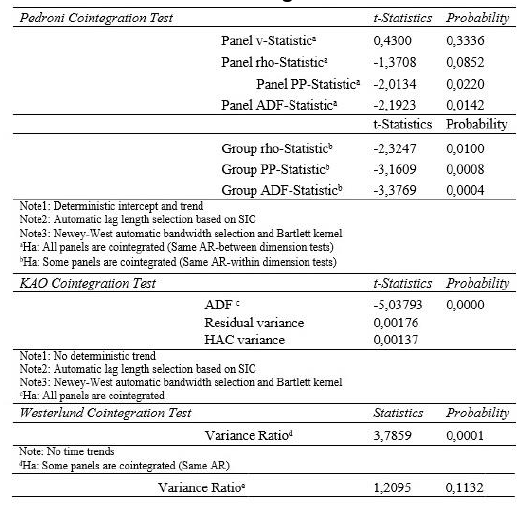
Table 6: Cointegration